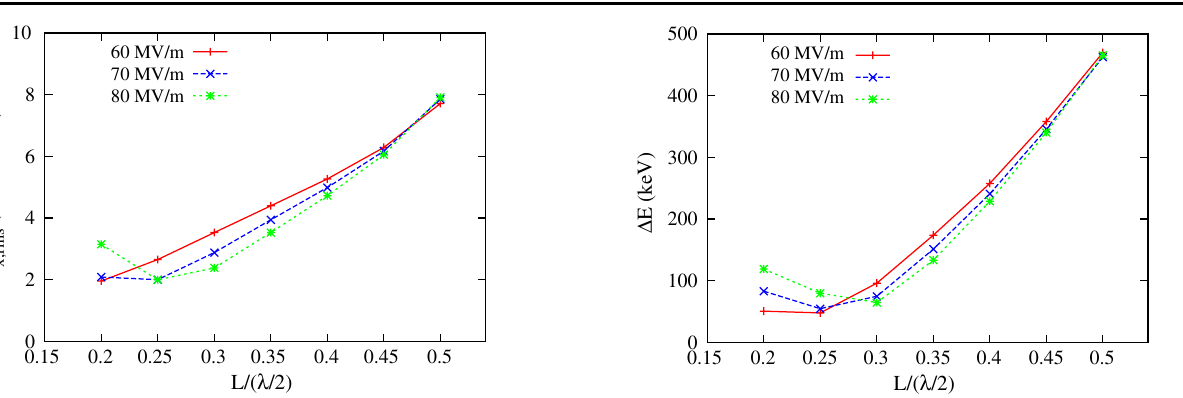
FIG. 6. Transverse emittance vs cathode cell length.